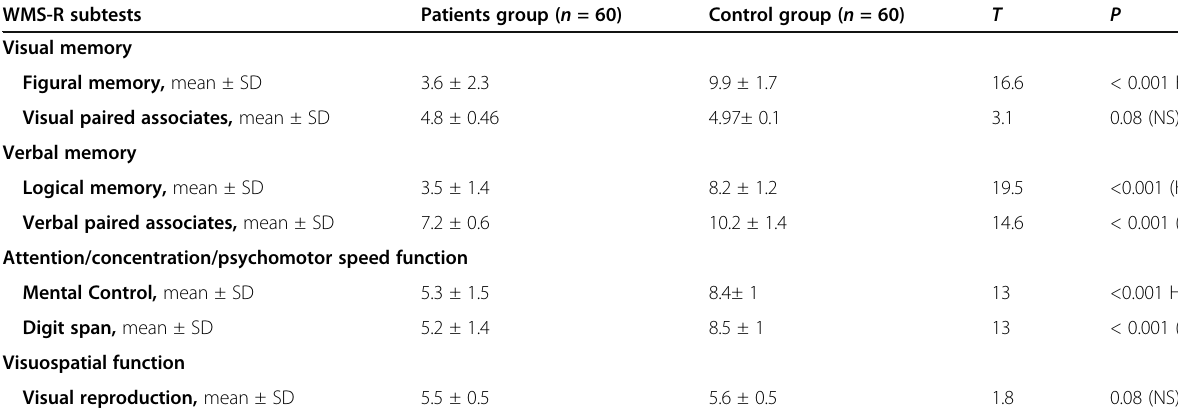
Table 3 Assessment of cognitive function by Wechsler memory scale WMS-R subtests